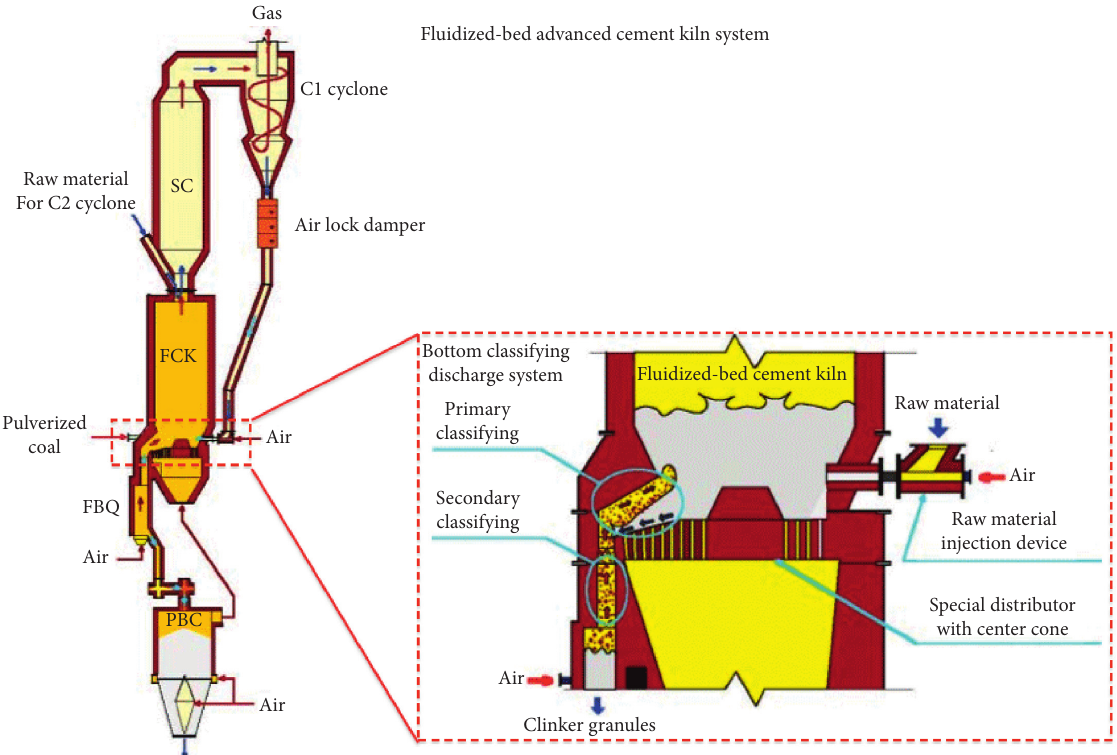
Figure 4: Fluidized-bed advanced cement kiln system